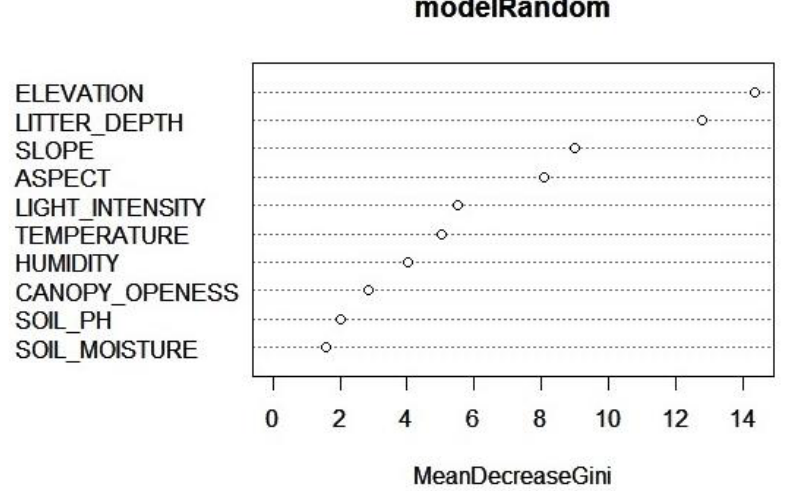
Figure 8. The importance of the ten explanatory variables for the response variable in determining species presence using RF. Table 3. The values of ten explanatory variables for the response variable in determining species presence using Random Forest (RF).